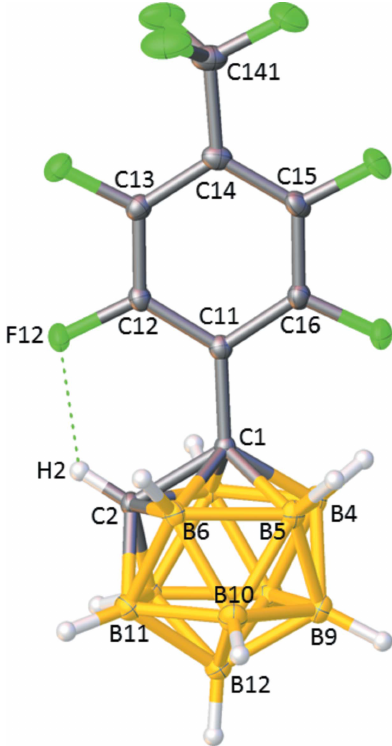
Figure 1 The molecular structure of [1-(4 0 -F 3 CC 6 F 4 )- closo -1,2-C 2 B 10 H 11 ] with key atoms labelled. Displacement ellipsoids are drawn at the 50% probability level, except for H atoms. The hydrogen bond between F12 and H2 is shown as a dotted line.